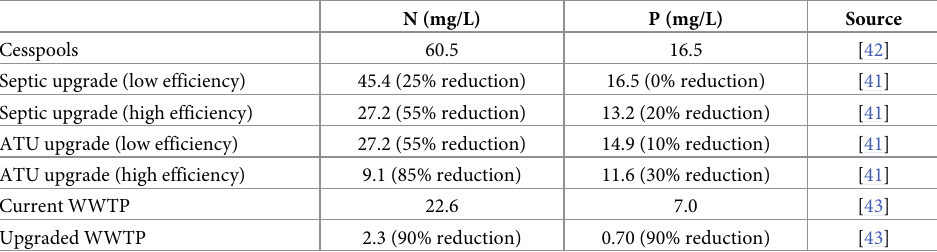
Table 2. Assumptions regarding nutrient concentrations in released effluent for wastewater treatment